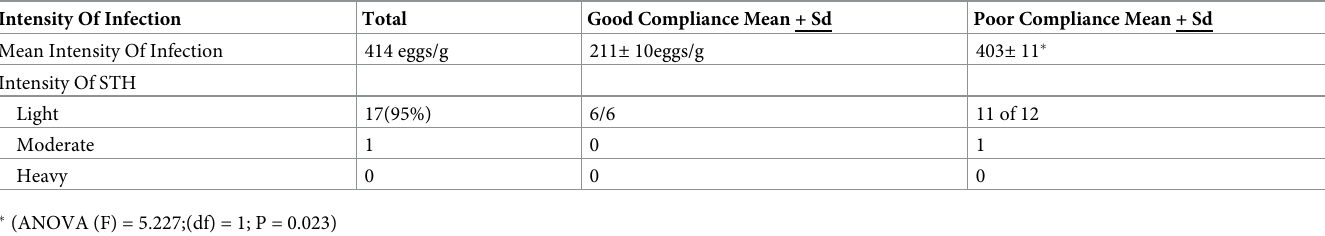
Table 6. Intensity of STH infection by compliance to hand hygiene of patients attending Arbaminch genral hospitals (from June to September 2021). Intensity Of